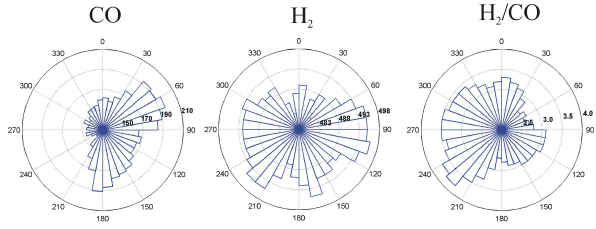
Fig. 4. Hydrogen and carbon monoxide in air masses arriving from the direction indicated by the 360 degree circle. 0 refers to winds arriving from north, and 90 east. The length of each 10 degree sector wedge is indicated by the numerical values inside the circle, either in ppb for CO and H 2 or in ppb(H 2 ) /ppb(CO) for H 2 /CO. The value refers to the mean mixing ratio (or H 2 /CO ratio) in current sector during June 2007–July